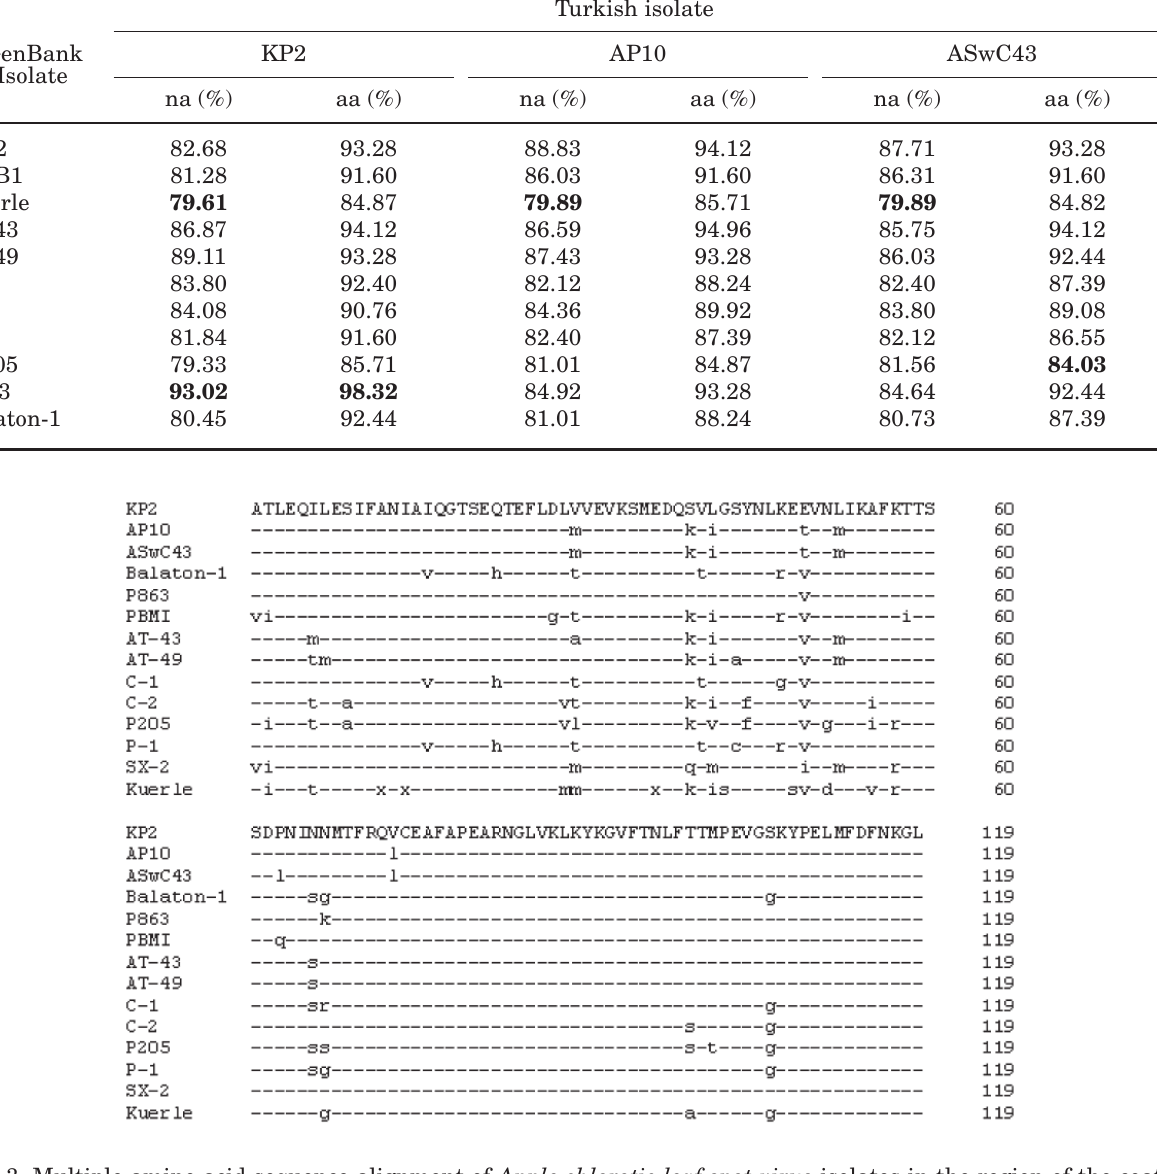
Fig. 3. Multiple amino acid sequence alignment of Apple chlorotic leaf spot virus isolates in the region of the coat protein gene. Dashes indicate conserved amino